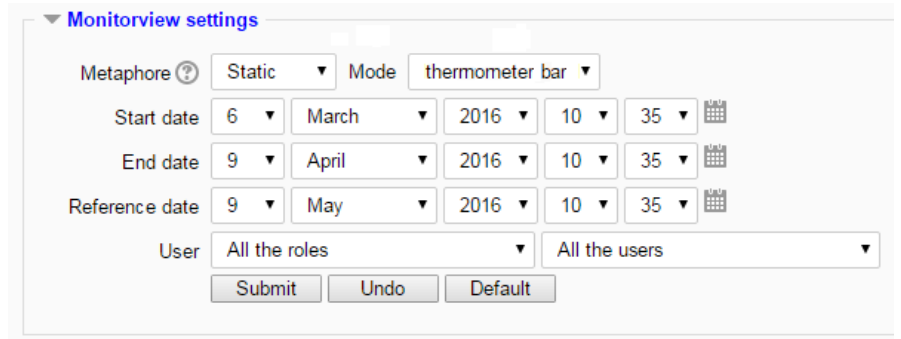
Figure 3. MonitorView parameter selection panel.